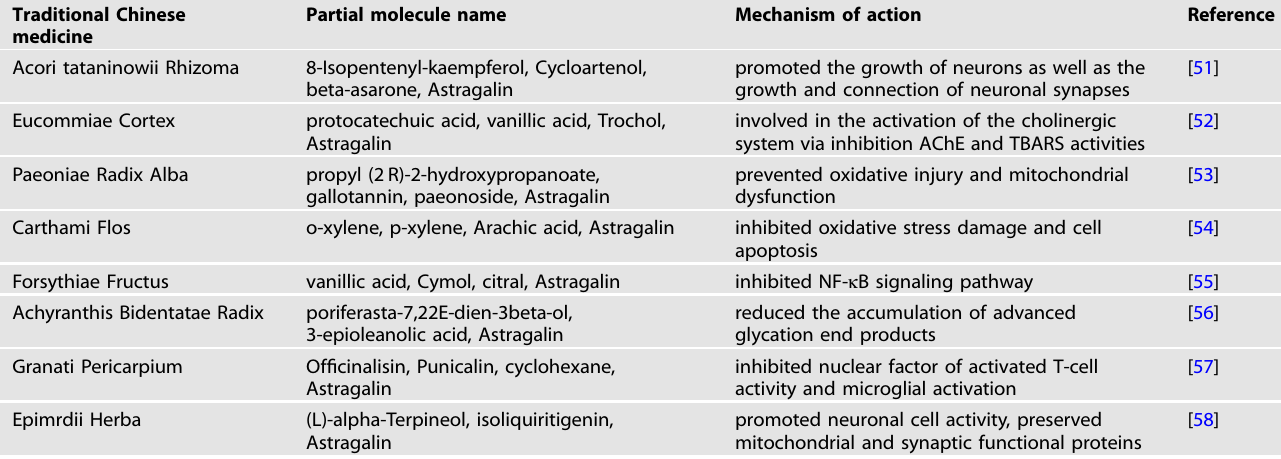
Table 1. Part of the components of Chinese herbal medicines for the treatment of